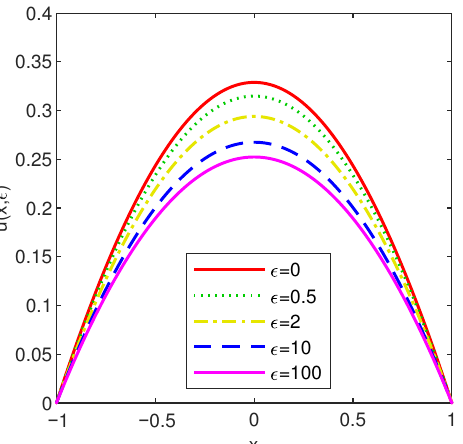
Figure 3. Chebfun solutions to problems (9) and (10) when δ : = 0.5 for various values of (cid:101) . The convergence of the method is exponential with the slope m approximately equaling − 0.3 in (7). Improper integrals